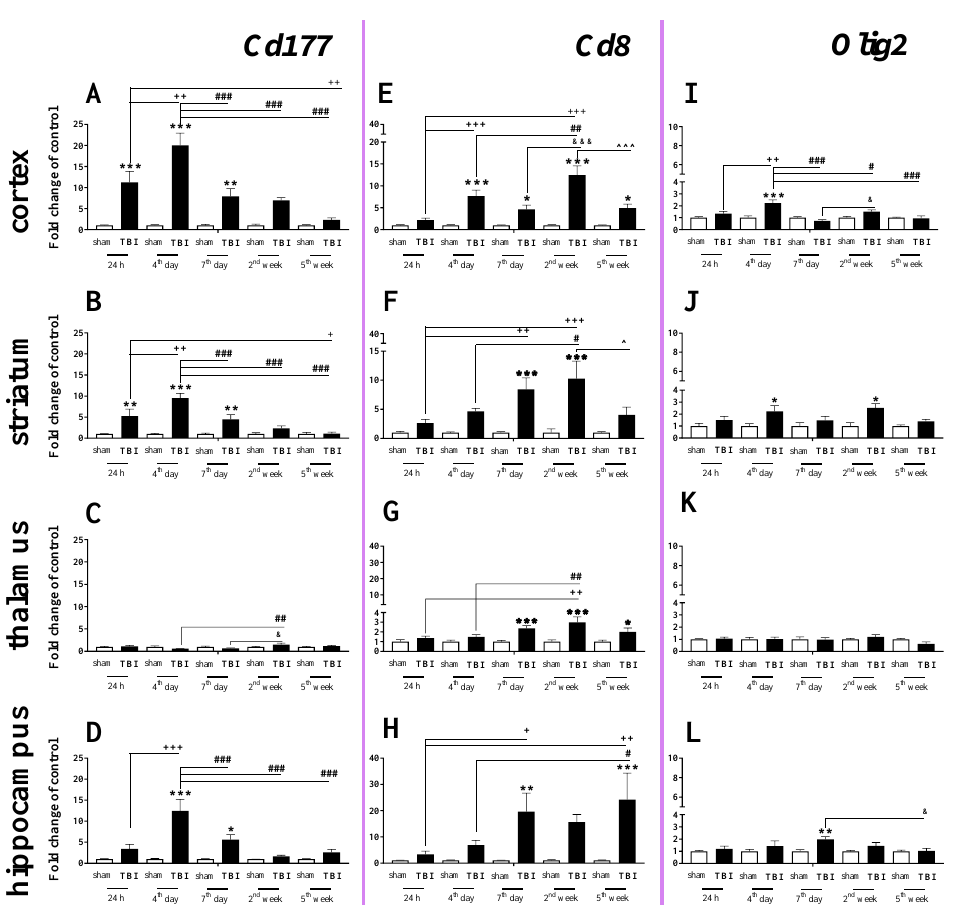
Figure 1. ( A – L ) . The mRNA expression changes of Cd177, Cd8 , and Olig2 in the cortex, striatum, thalamus, and hippocampus of TBI compared to sham-injured animals at different time points (24 h–5 weeks). The data are given as fold changes relative to the control as mean ± SEM (standard error of the mean) (sham groups, n = 5–8; TBI groups, n = 4–8). * p < 0.05; ** p < 0.01; *** p < 0.001 show differences considered statistically significant between the sham and TBI groups, + p < 0.05; ++ p < 0.01; +++ p < 0.001 show differences considered statistically significant comparing to the 24 h TBI group; # p < 0.05; ## p < 0.01; ### p < 0.001 show differences considered statistically significant comparing to the 4th day TBI group; & p < 0.05; &&& p < 0.001 show differences considered statistically significant when comparing to the 7th day TBI group; ^ p < 0.05; ^^^ p < 0.001 show differences considered statistically significant comparing to the 2 weeks TBI group as estimated by two-way ANOVA followed by Bonferroni’s post hoc test.